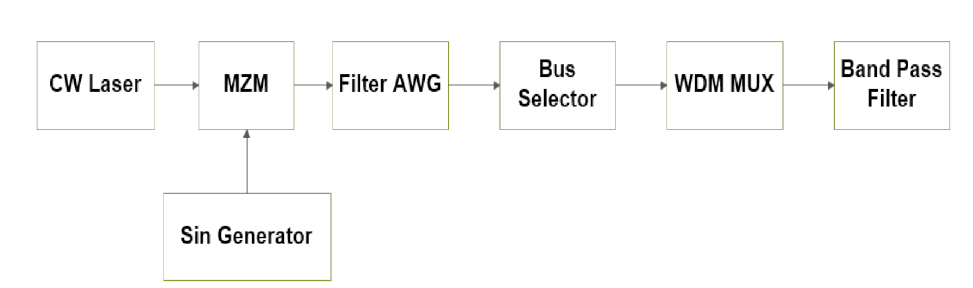
Figure 4. Block diagram of the generation of millimeter waves. CW: Constant Wave; MZM: Mach- Zehnder Modulator; AWG: Arrayed Wavelength Grating; WDM: Wavelength Division Multiplexing; MUX: Multiplexer.